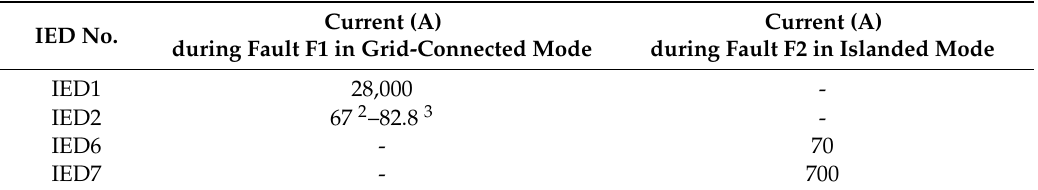
Table 3. Fault currents (RMS) at considered IED locations with DG scenario-4 (F1 in grid-connected mode and F2 in islanded